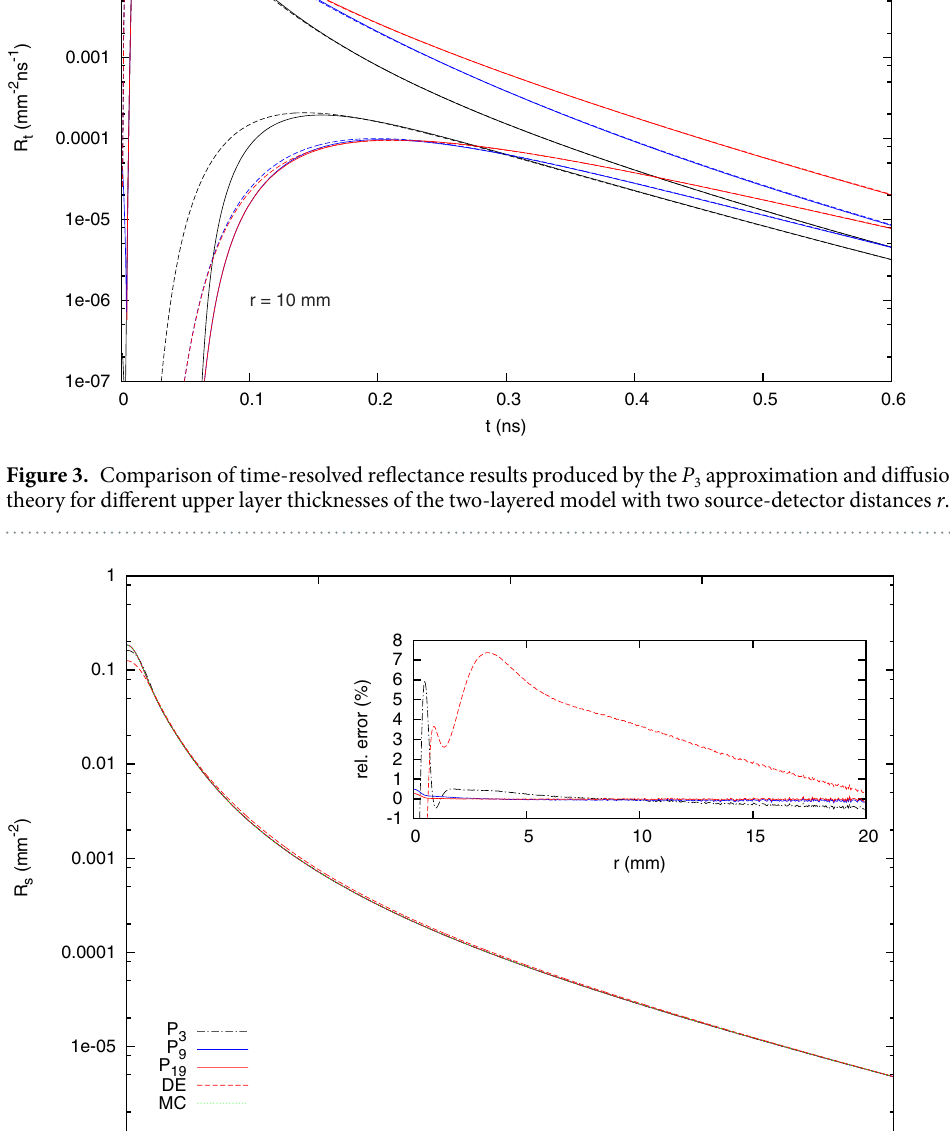
(3) 1 and a refractive index of n = 1.4 due m a